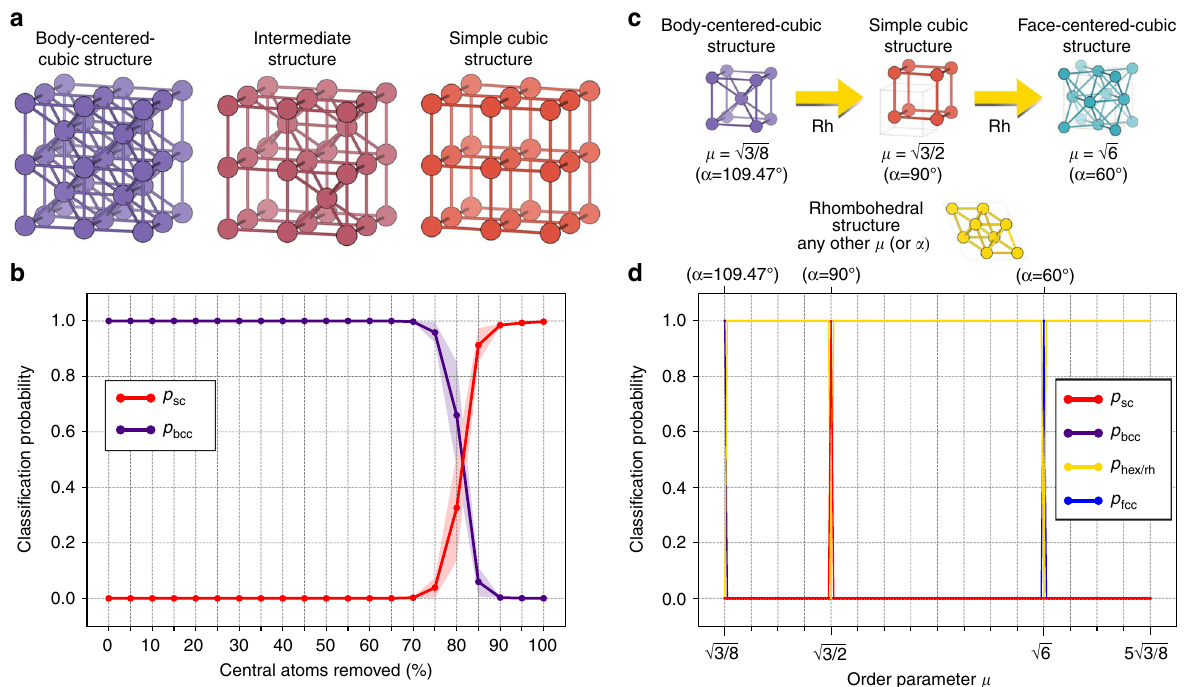
Fig. 4 Neural network predictions on structural transitions. a , b Body-centered-cubic (bcc) to simple cubic (sc) structural transition. a Examples of a bcc, an intermediate bcc/sc, and a sc structure. b Distributions of classi fi cation probability for the bcc (purple) and sc (red) classes as a function of the percentage of central atoms being removed (see text for more details). The shaded area corresponds to a range of one standard deviation above and below